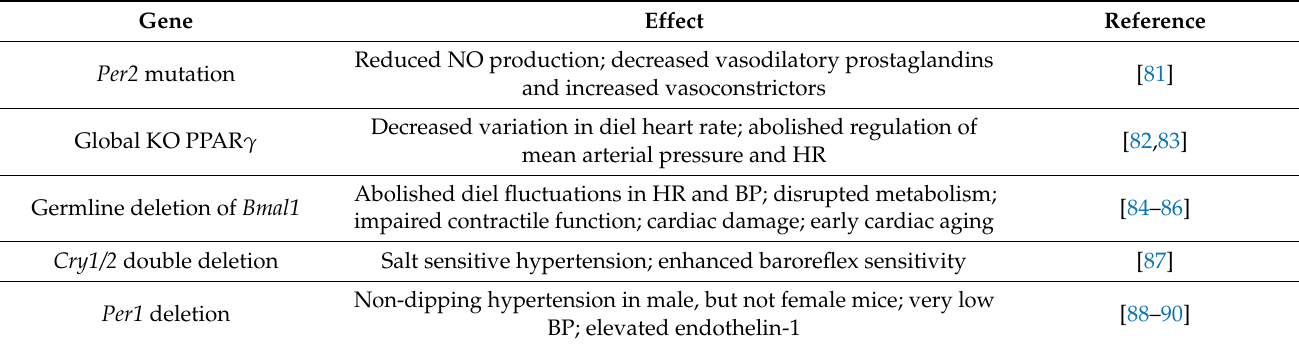
Table 1. Effects of clock gene mutations on cardiovascular function and